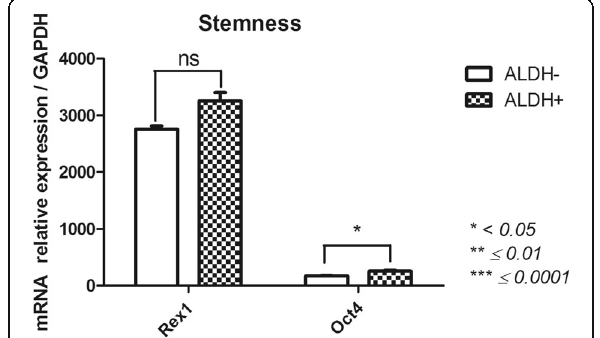
Fig. 3 Stemness-related gene expression profile of FSK-MSC subsets according to ALDH activity. After flow cytometry sorting of ALDH + and ALDH − FSK-MSC subsets, we investigated by qPCR the expres- sion profiles of pluripotency-associated genes Oct4, Nanog and Rex1. Data are presented as mean ± SEM of mRNA gene expression relative to GAPDH expression. (ns = non